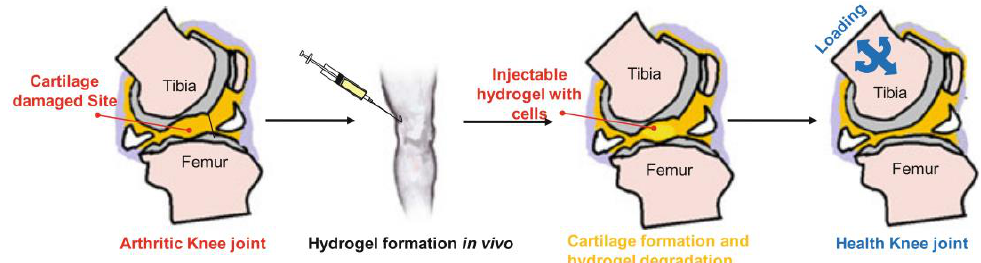
Figure 7. Schematic overview of cartilage tissue engineering using injectable hydrogels. The image has been taken from the publication by Dehghani et al. [32] with